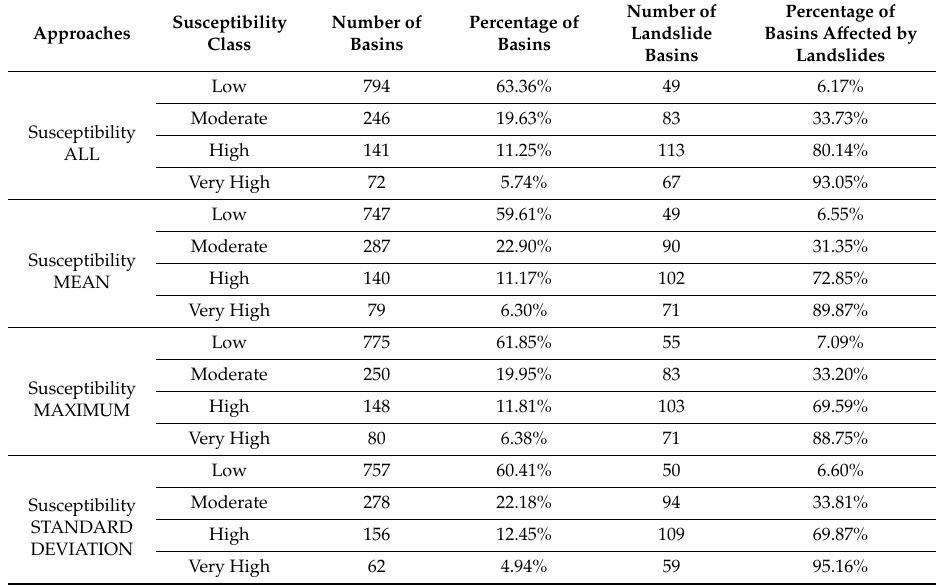
Figure 8. Receiver operating characteristic (roc) curves of the four model configurations. Table 2. Summary statistics of the subdivision of the basins into susceptibility classes, according to the di ff erent approaches pursued in the